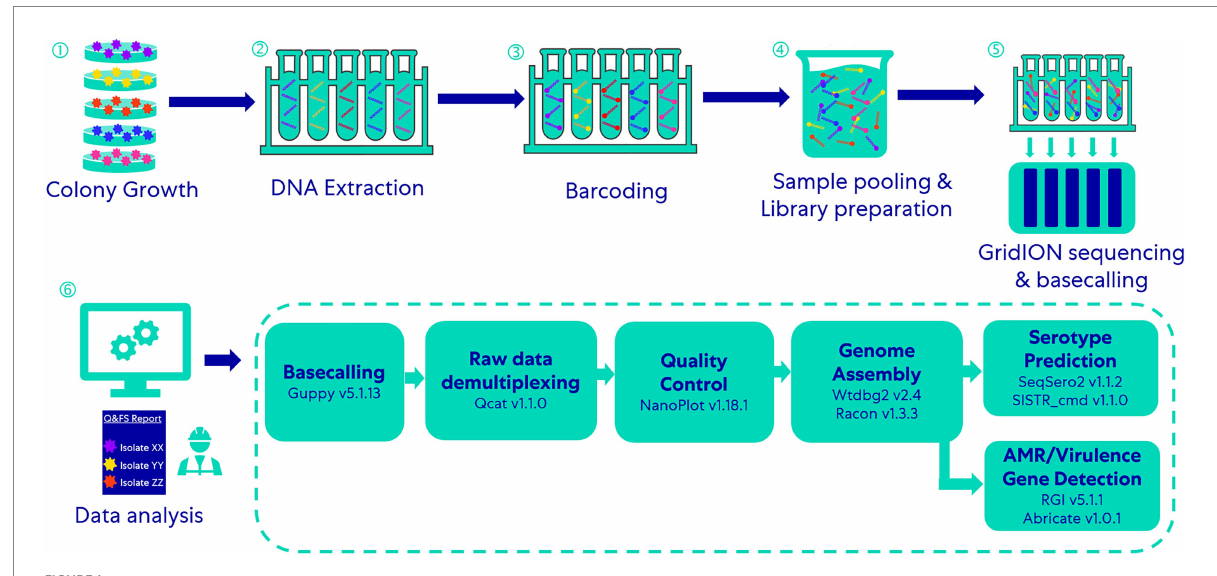
FIGURE 1 Workflow of the multiplex-ONT-sequencing-based WGS method for Salmonella serotype prediction and AMR/virulence gene